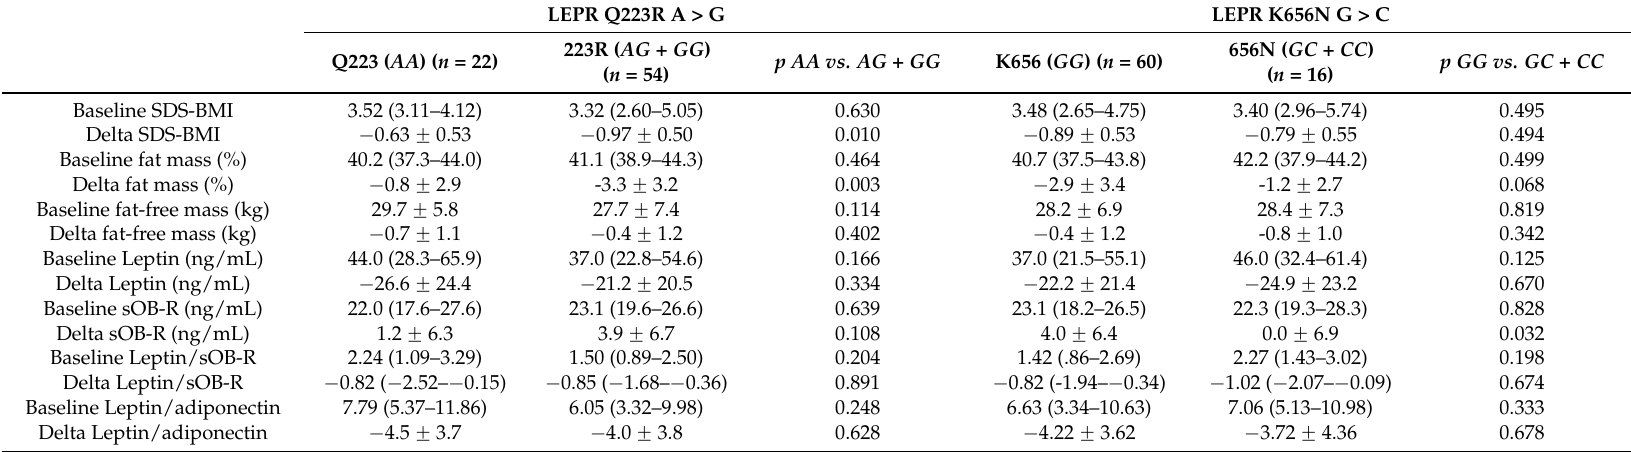
Table 5. Associations of LEPR Q223R and K656N polymorphisms with level of adipokines and body composition before and after 3-month